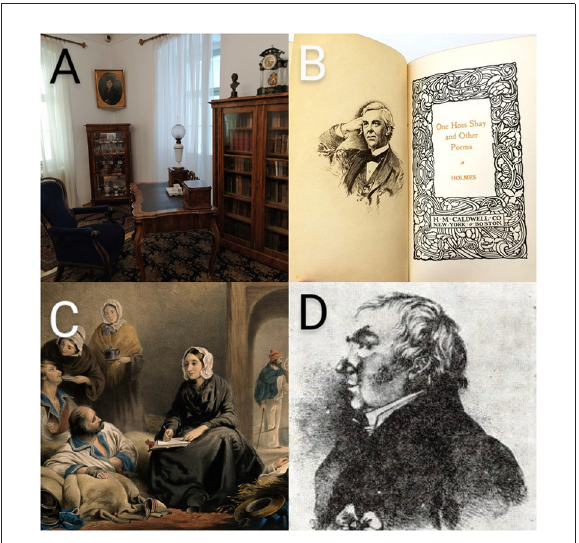
FIGURE2 (A) The memorial room of the HNM Semmelweis Museum, Library and Archive of the History of Medicine, rearranged from the estate and furniture of Ignác Semmelweis. Photo by P. Poczai. (B) Holmes was a physician by profession but gained popularity as a writer; he was one of the nineteenth century’s most esteemed American poets. (C) Florence Nightingale visiting patients on the colored lithograph of R. Burgess. Portrait courtesy of the Wellcome Institute, London (No. 2151.25). (D) The only surviving depiction of János